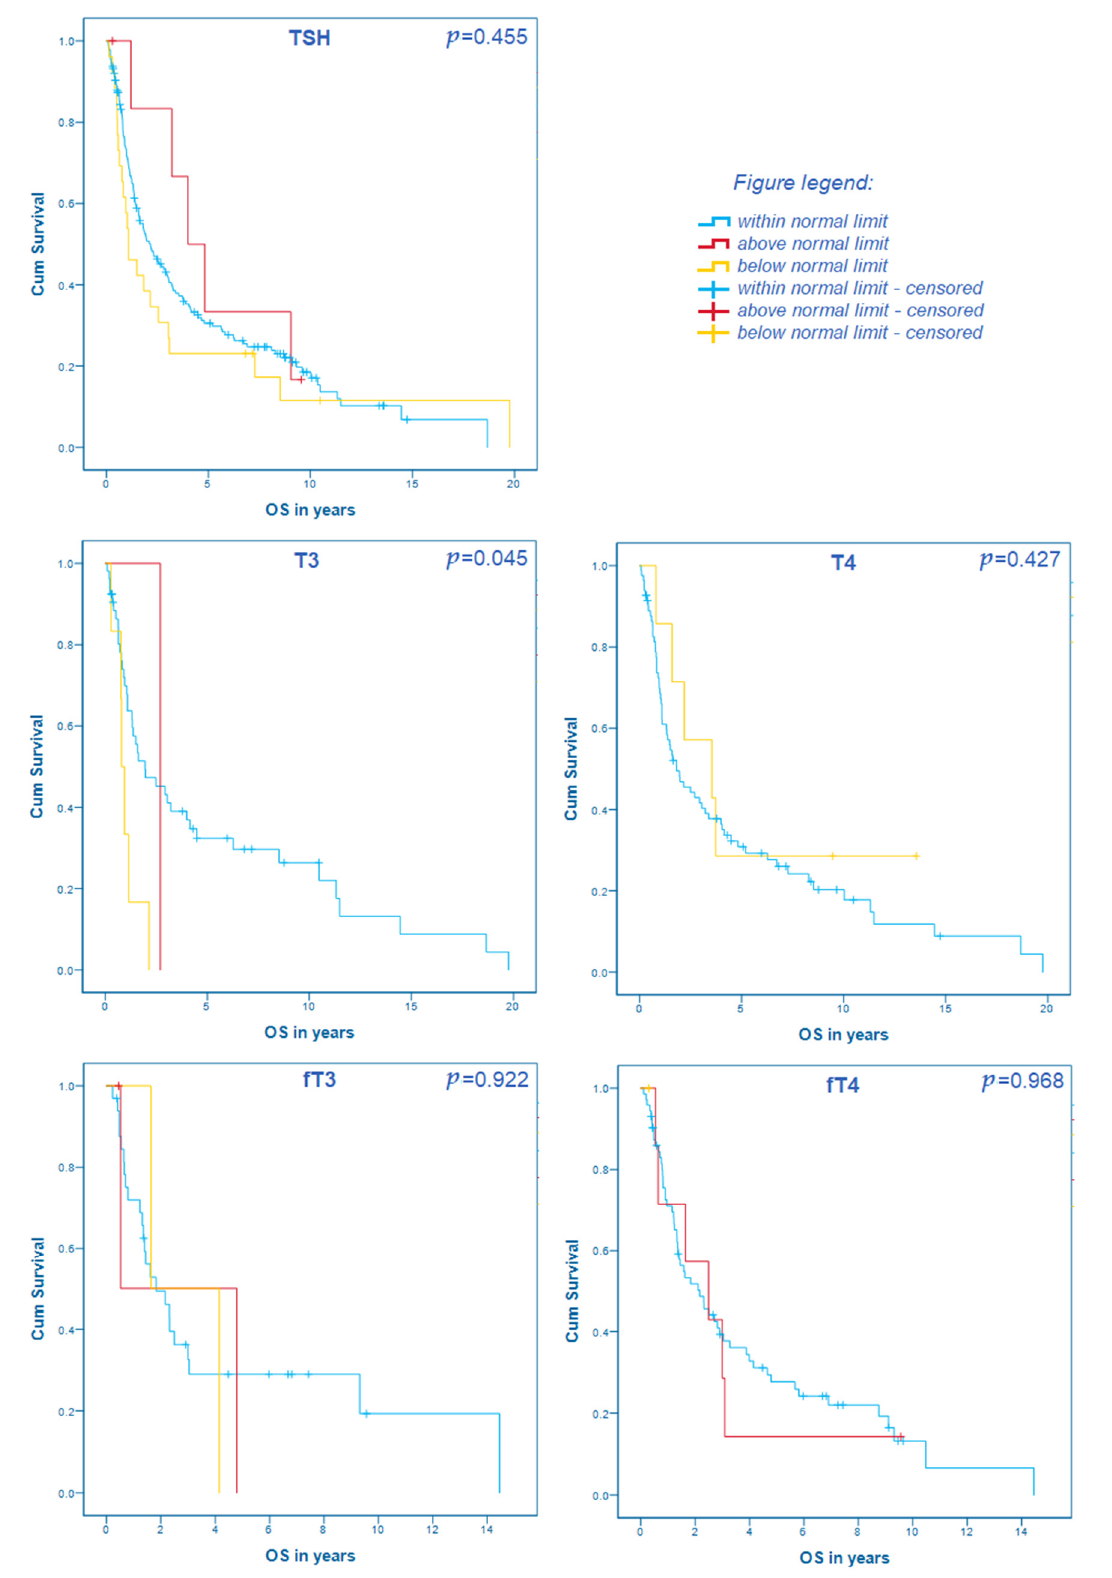
Figure 1. The correlation of thyroid hormone levels within, above, and below normal limits with the overall survival in patients with resectable gastroesophageal cancer.